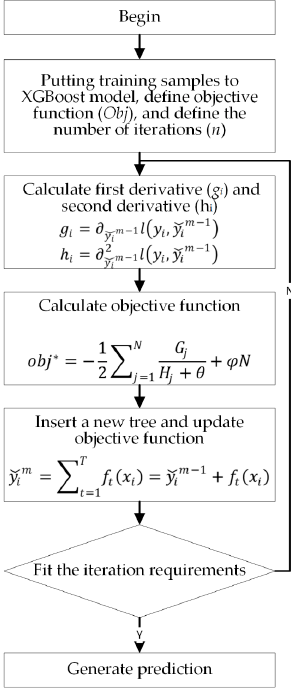
Figure 2. Principles of the XGBoost algorithm used as a predictive model.